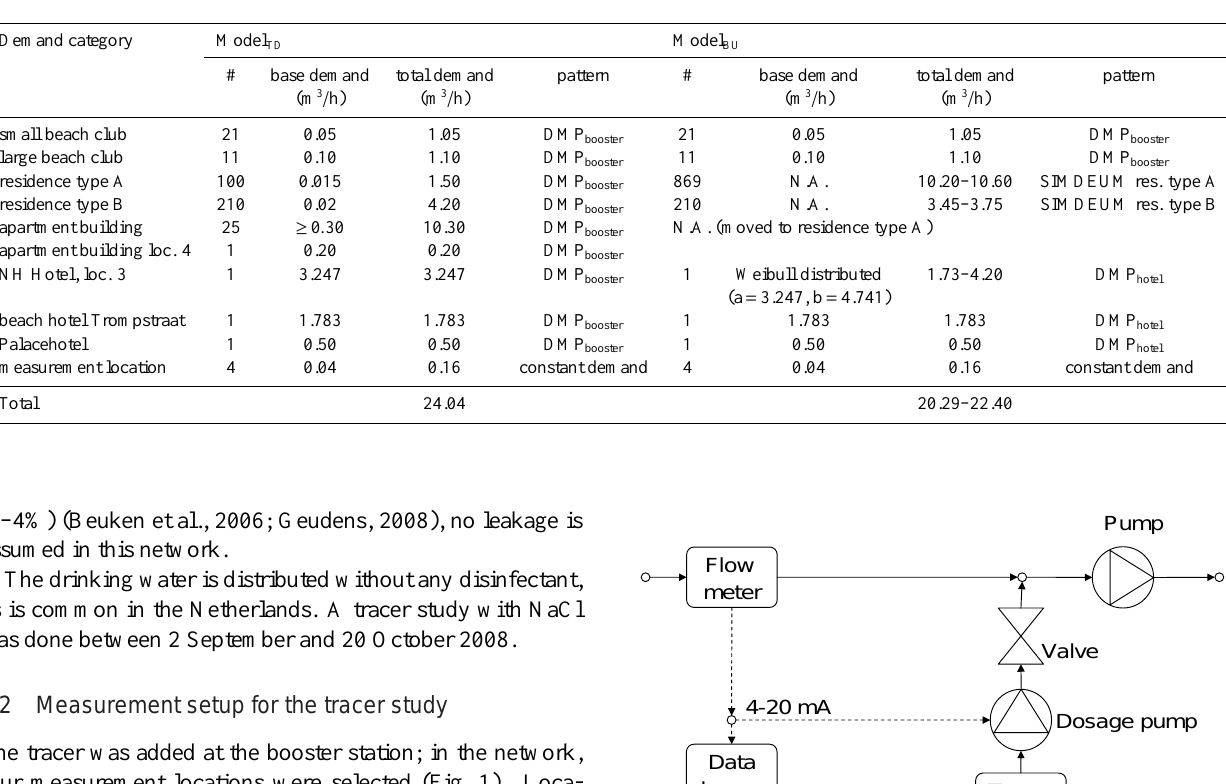
Table 2. Demands in Model TD and Model BU , # units with given base demand are reported; these are not all connected to an individual demand node.